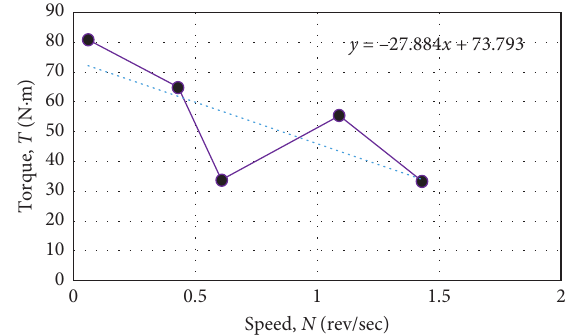
Figure 6: Torque vs. speed for the non-Newtonian fluid to de- termine “ g ” and “ h ” which are equal to “ τ 0 ” and “ μ. ” Hence, τ 0 � 73.793 and μ �− 27.884. The apparent viscosity is calculated by the formula, η app � ( τ 0 / K × N )+ μ , 35.11 � 73.79/( K × N ) �− 27.88,